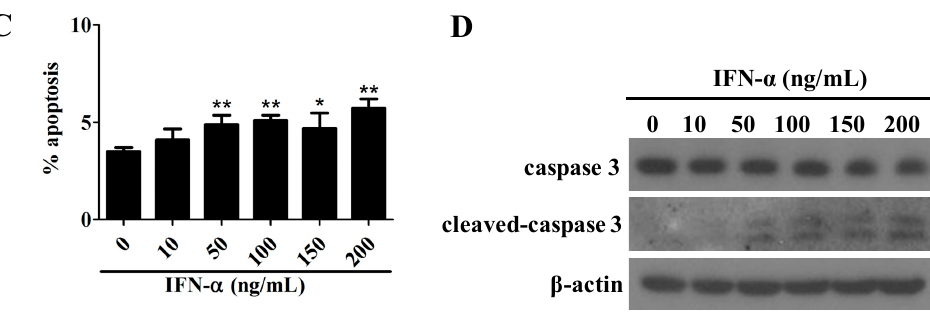
Figure 2. IFN- α promotes apoptosis of HeLa cells. ( A ) Flow cytometric analysis on HeLa cell apoptosis after IFN- α treatment. HeLa cells were first seeded onto a 12-well culture plate and treated with different doses of IFN- α . After 48 h culture, the cells were harvested and subjected to annexin V/propidium iodide (PI) double staining followed by flow cytometric analysis; ( B ) Quantitation of the apoptosis of the HeLa cells after IFN- α treatment. The IFN- α -treated HeLa cells were prepared as described in ( A ) and subjected to annexin V/PI double staining. Each value is represented as mean ± SD from three independent experiments. After statistical analysis, results were considered to be significant if p < 0.05 (*) or p < 0.01 (**); ( C ) The dose effect of IFN- α -induced apoptosis in HeLa cells. HeLa cells were treated with six increasing doses of IFN- α (0, 10, 50, 100, 150, and 200 ng/mL) for 48 h, then, cell apoptosis was detected with annexin V/PI double staining followed by flow cytometric analysis. Each value is represented as mean ± SD from three independent experiments. After statistical analysis, results were considered to be significant if p < 0.05 (*) or p < 0.01 (**); ( D ) Western blot analysis on the activation of caspase 3. The whole-cell